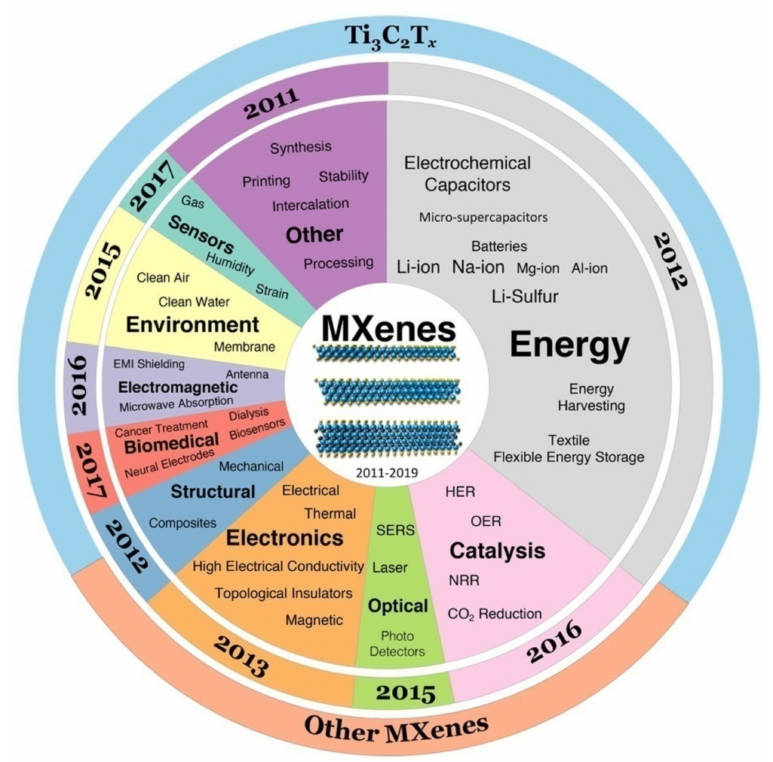
Figure 9. Mxene applications: The pie chart depicts the MXene applications in various sectors explored. Center pie chart depicts the no. of publications made for the applications mentioned. The middle ring shows the year of onset of those publications; i.e., the breakthrough works with most impact. The last ring shows the ratio of explored Ti 3 C 2 T x to other MXenes. Adapted with permission from [107] (Gogotsi, 2019). Copyright © 2019 American Chemical